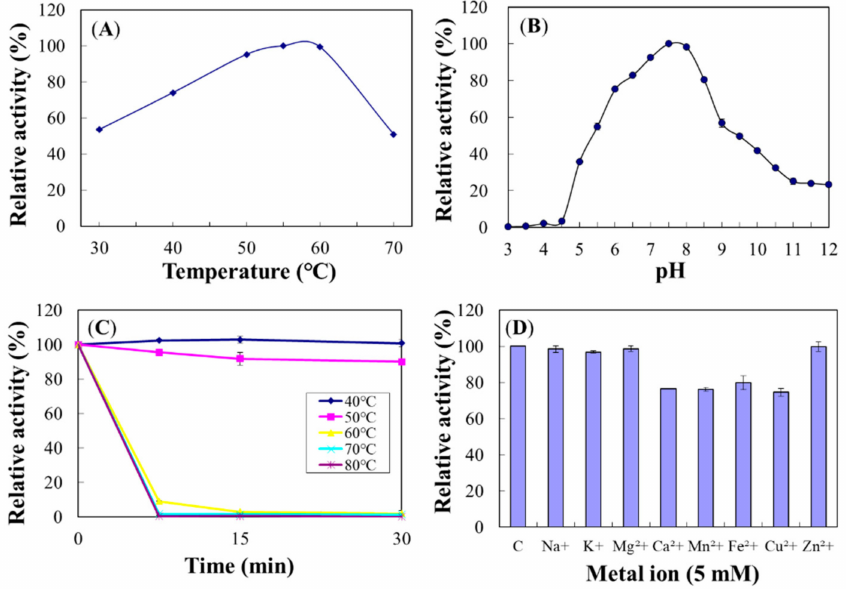
Figure 13. Effects of temperature ( A ), pH ( B ), thermostability ( C ), and metal ions ( D ) on the enzyme activity of Chi18C. The properties were characterized using the DNS method with colloidal chitin as a